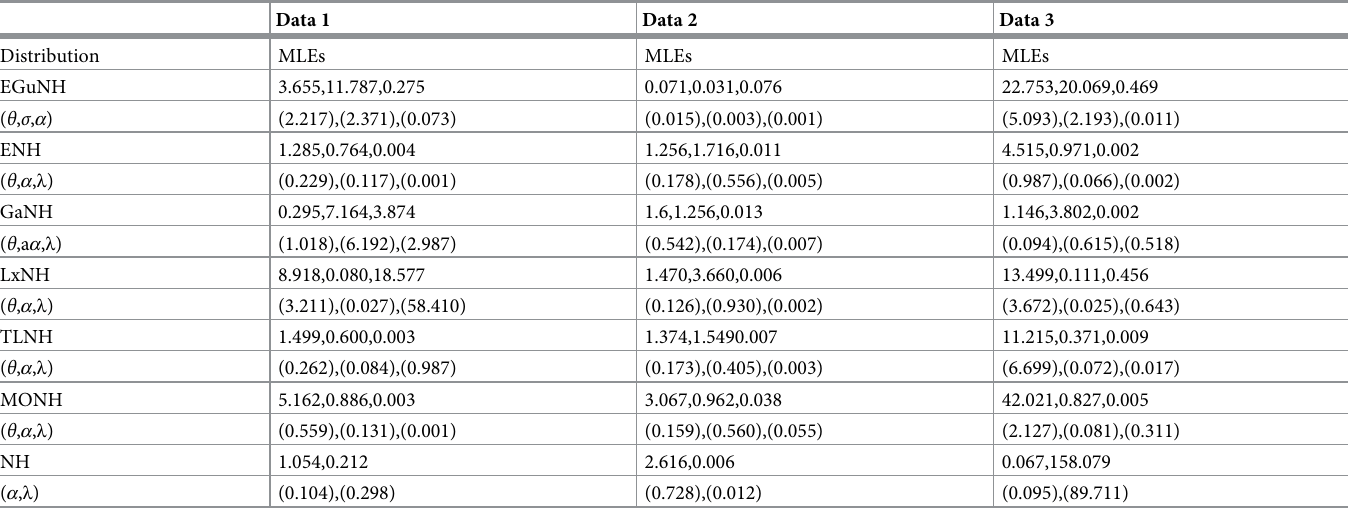
Table 10. MLEs with their respective SEs (in parenthesis) for D1, D2 and D3. Data 1 Data 2 Data 3